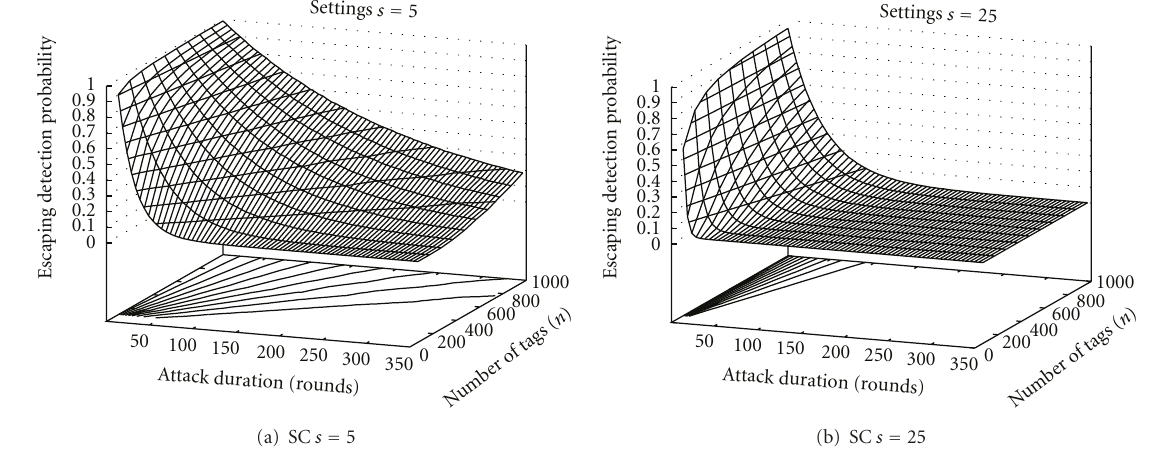
Figure 5: Static counter (SC) security performance: e ff ects of parameter p .